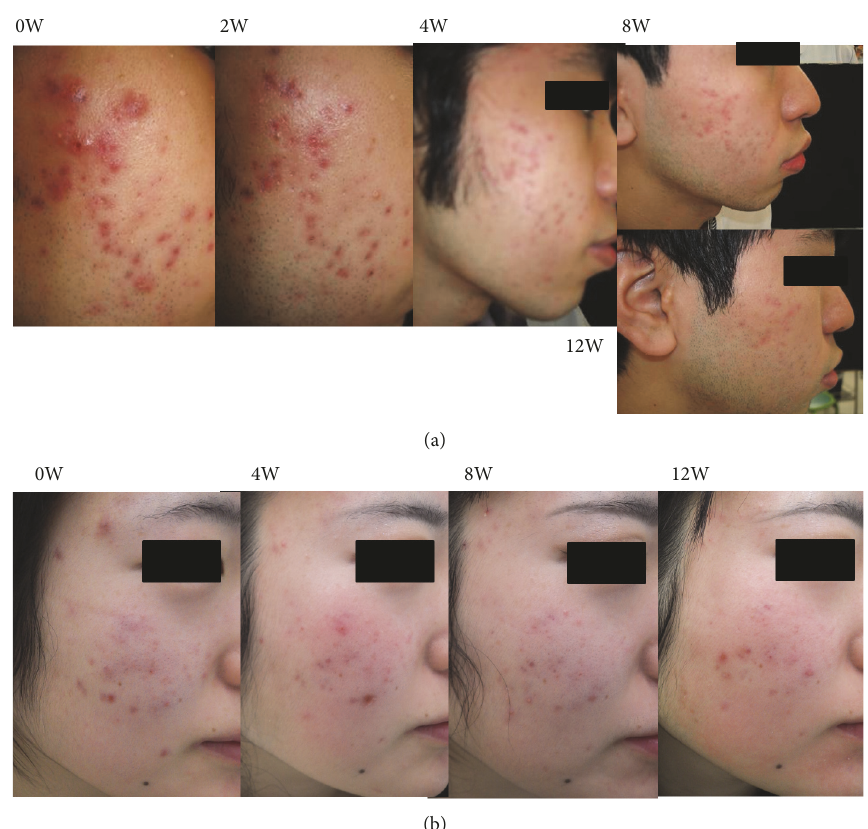
Figure 2: Representative images of patients treated with Keigairengyoto . Acne in two representative patients ((a) and (b)) treated with Keigairengyoto (KRT) at study entry and at weeks 2, 4, 8, and